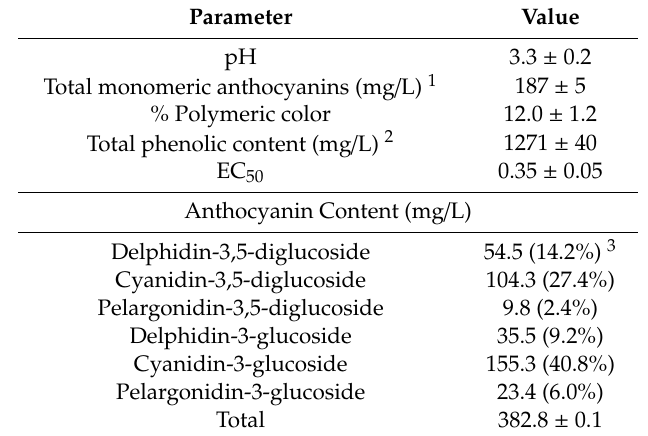
Table 1. Chemical characteristics of pomegranate juice (PJ) from the Ermioni